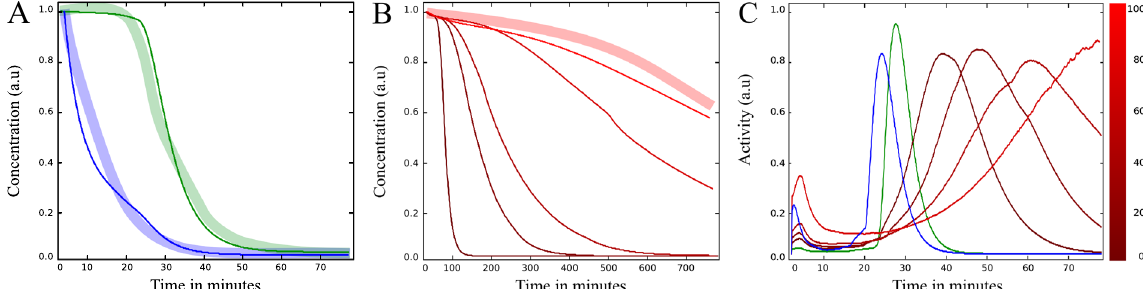
Figure 5. Securin behavior under different treatments. Thin lines are simulation data. Thick lines represent data points from Dick et al . Fig. 5 11 . The colorbar on the right represents the concentration of nocodazole in ng ml − 1 . ( A ) Total concentration of Securin over time, normalized at prometaphase onset (time = 0). The green curve shows the unperturbed system, in which Securin starts degrading at a significantly higher rate once kinetochores start attaching. The blue curve shows the influence of Mad2 targeting siRNA, simulated through the reduction of the Mad2 initial concentration. Here, APC/C:Cdc20 is not captured by MCC and Securin starts degrading immediately. ( B ) The same as in A, but under the influence of different concentrations of nocodazole, modeled by a stepwise decrease of the rate k attach . Curves are shown for concentrations in the range 1–100 ng ml − 1 nocodazole. ( C ) The degradation rate of Securin (control in green, targeting siRNA in blue and nocodazole in red). As the rate peaks briefly before anaphase onset, these curves demonstrate how different drugs can arrest the cell in metaphase and delay anaphase.